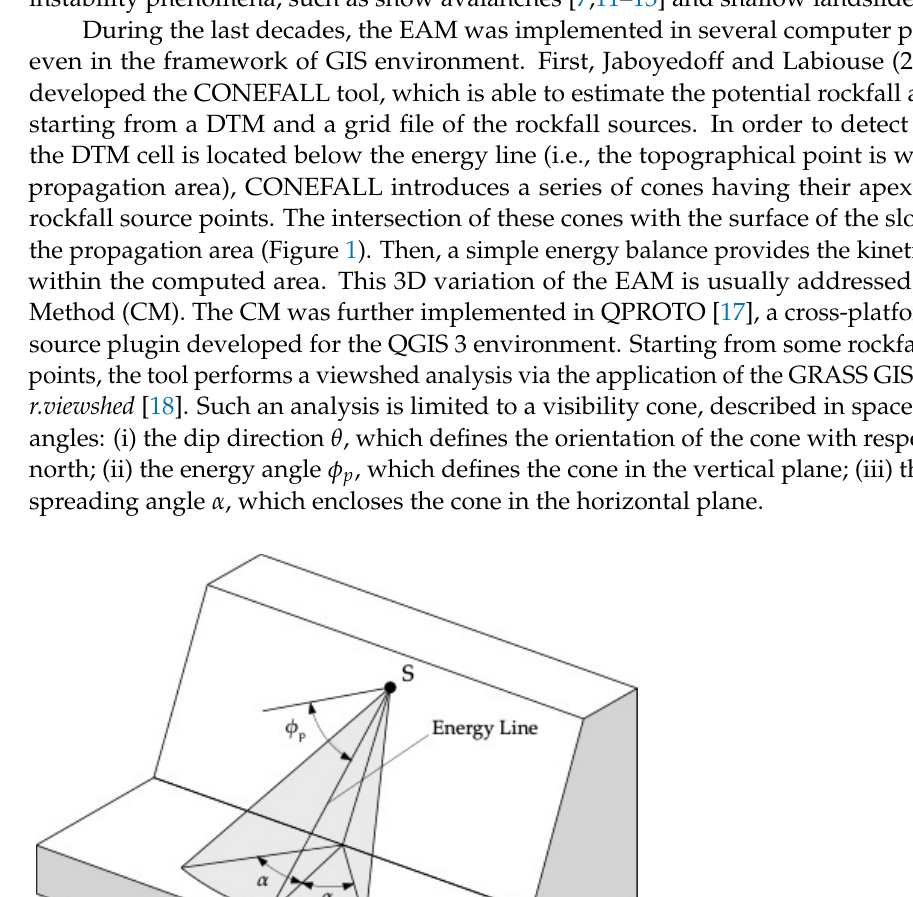
Figure 2. 3D sketch of the cone generation within the QPROTO plugin. The cone originates from the S(x 0 ,y 0 ) point and is sectioned by a vertical plane passing through the generic topographic point P(x,y) . The light grey shows the volume of the cone, which is limited by the topographic surface and the plane defined by the energy line (orange line). The horizontal dark green line re- fers to the total energy of the block. Thus, it is possible to obtain the kinetic energy E k (x,y) at each point of the cone adopt- ing the following relationship (Equation (2)): 𝐸 (cid:3038) (𝑥, 𝑦) = 1 2 𝑚(cid:4670)𝑣(𝑥, 𝑦)(cid:4671) (cid:2870) (2) where m is the mass of the block and v(x,y) its velocity at the point P(x,y) . It has to be considered that the calculated energy does not take into account the com- bination of free flight, bouncing, rolling and sliding phenomena that actually occur during the propagation phase: all these phenomena are simulated through an equivalent sliding motion along the above-mentioned plan with inclination equal to 𝜙 (cid:3043) . Velocity and energy